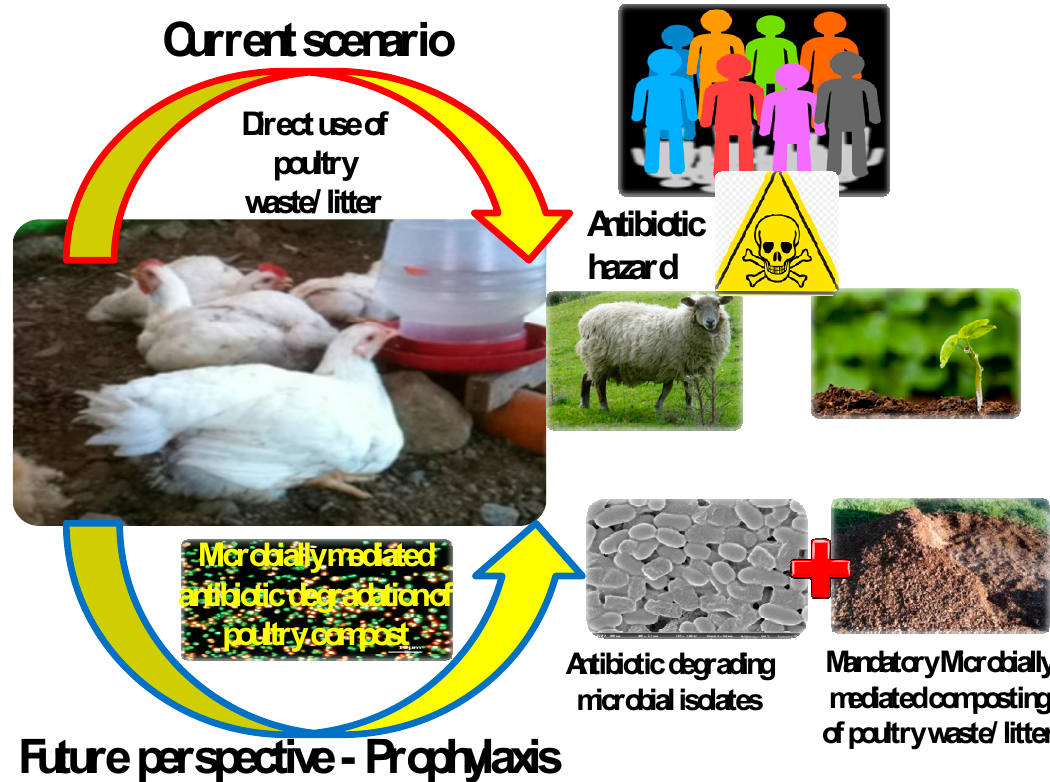
Figure 1. Schematic emphasizing the futuristic environmentally friendly and promising microbially accelerated poultry waste/litter composting.